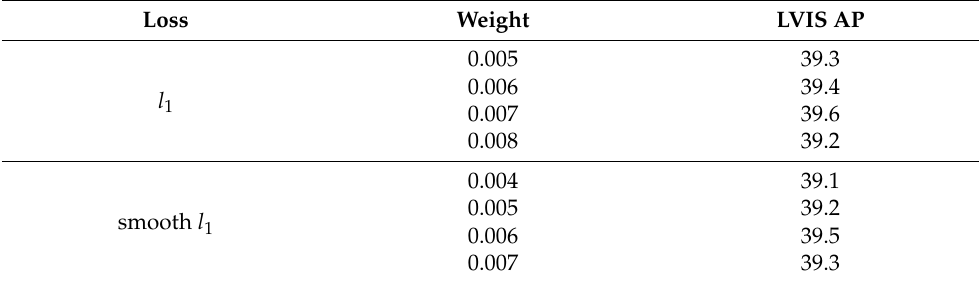
Table 1. The results of loss with different weights.